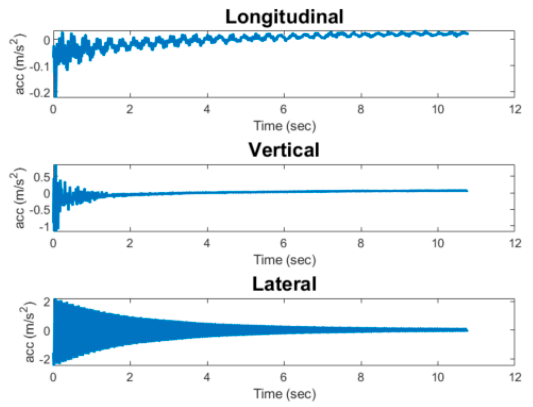
Figure 12. Acceleration record of test event.